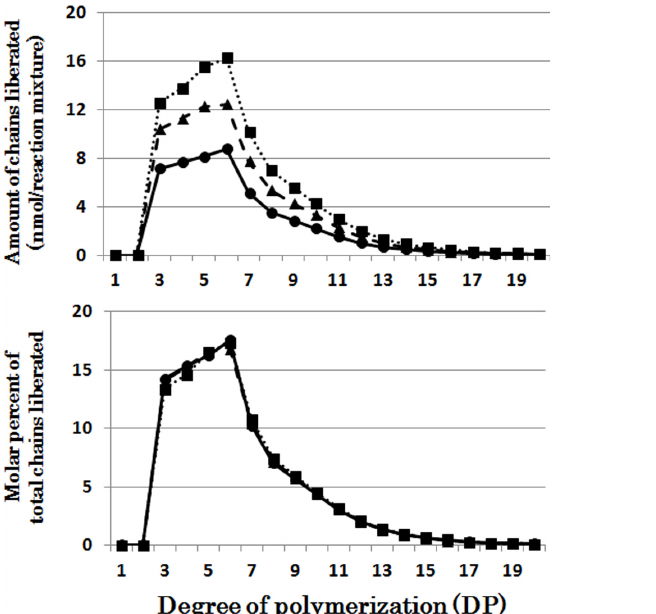
Fig 5. Chain-length preference of Synechococcus elongatus PCC7942 isoamylase1 (ScoISA) in debranching phytoglycogen. Upper panel shows the amount of chains liberated after enzymatic reaction with ScoISA and phytoglycogen for 5 ( ● ), 10 ( ▲ ), and 30 ( ■ ) min, respectively. Lower panel shows the molar percentage of each liberated chain to the total liberated chains.